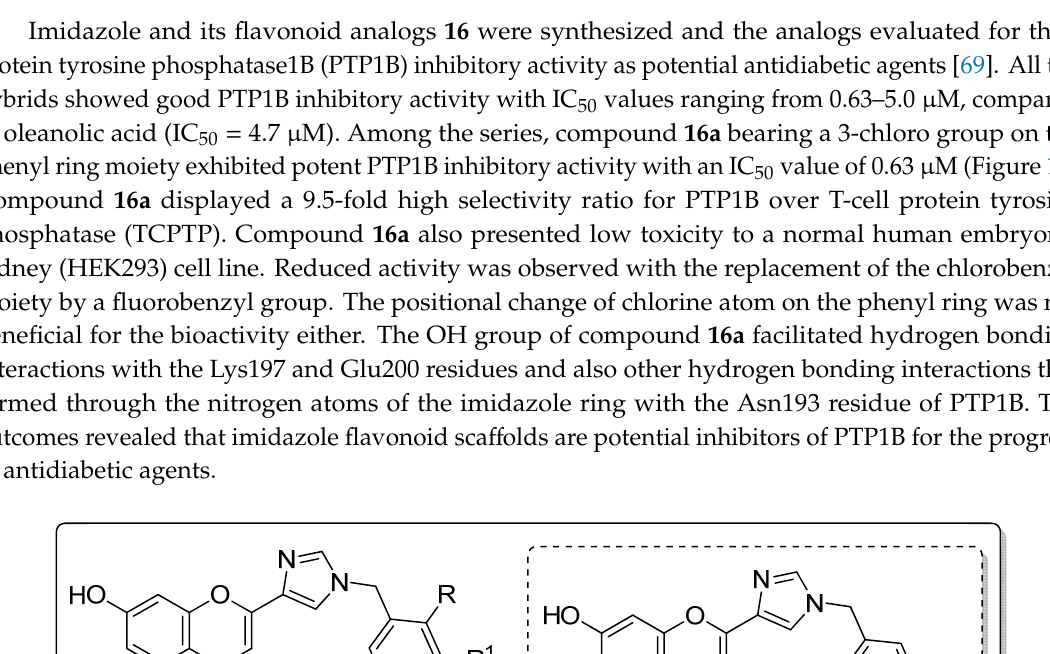
Figure 18. Antiproliferative activity of the most active 2 ‐ arylimidazole derivative 15a .